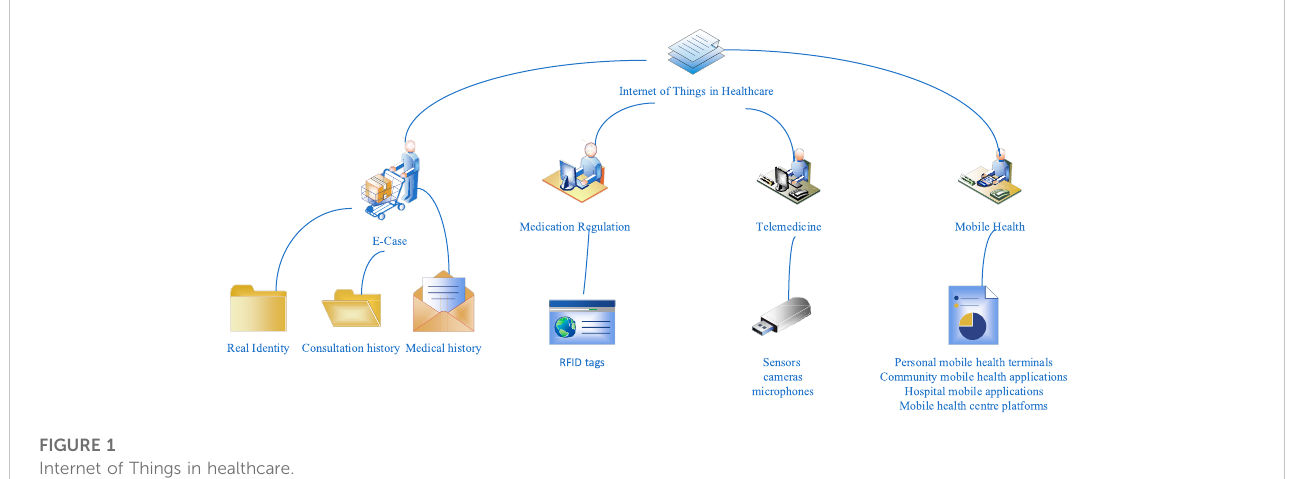
FIGURE 1 Internet of Things in